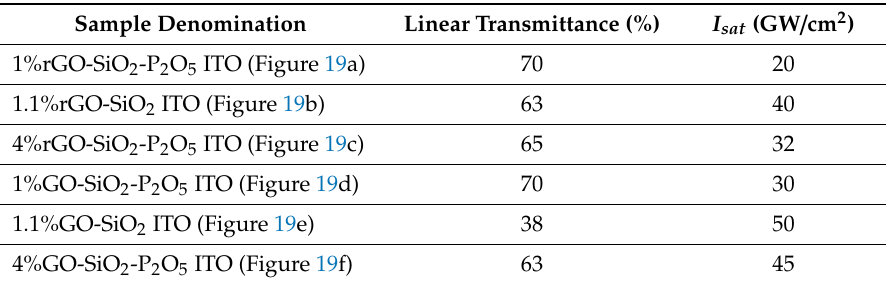
Table 4. The linear transmittance and the saturation intensity derived from Figure